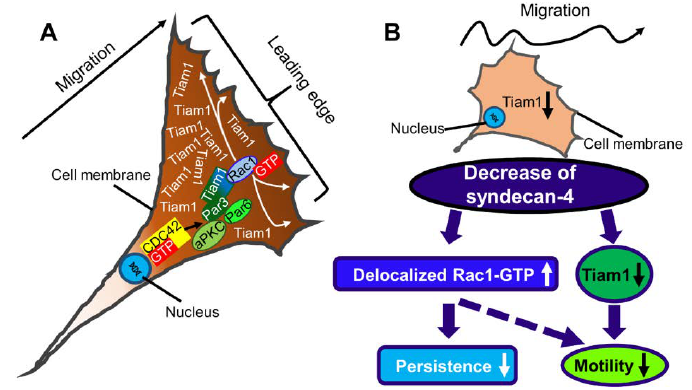
Figure 5. ( A ) Schematic representation of a migrating cell with a characteristic shape. The direction of migration is well defined, and the Tiam1 is asymmetrically accumulated at the leading edge resulting in Rac1 activation and lamellipodia formation. ( B ) Knocking-down of syndecan-4 resulted in decreased Tiam1 expression, abrogated the asymmetrical distribution of Tiam1, decreased the directional persistence of the movement, and decreased cell motility. Par3, Par6: Partitioning defective 3,6; aPKC: atypical PKC; Tiam1: T-lymphoma invasion and metastasis-1; : increase; :